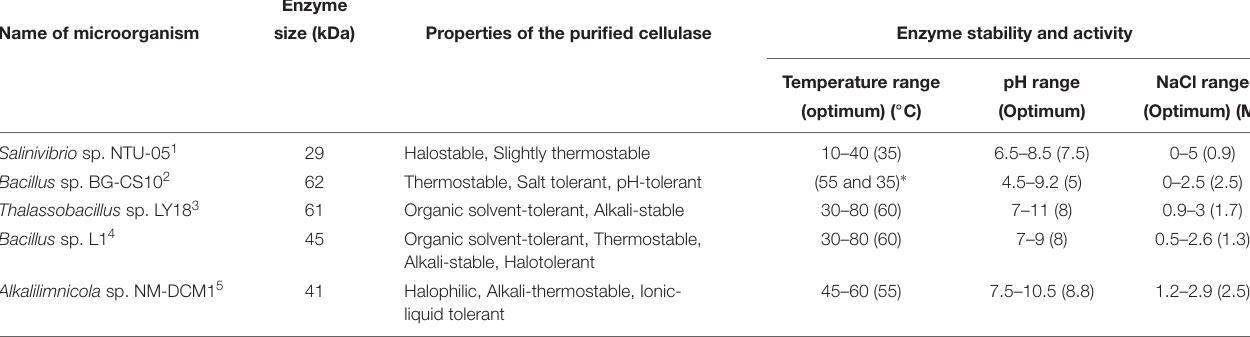
TABLE 2 | Purified cellulase enzymes from halophile bacteria ∗ .